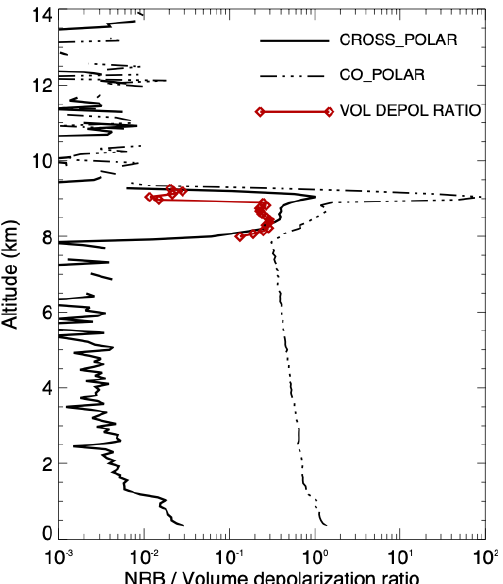
Figure 3. Profiles of the cross-polar (solid line) and co-polar (dash– dotted line) components of the NRB for a mixed-phase cloud at GSFC on 5 October 2019 (06:40UTC). The volume depolarization ratio within the cloud layer is indicated by the red line (diamond symbol).